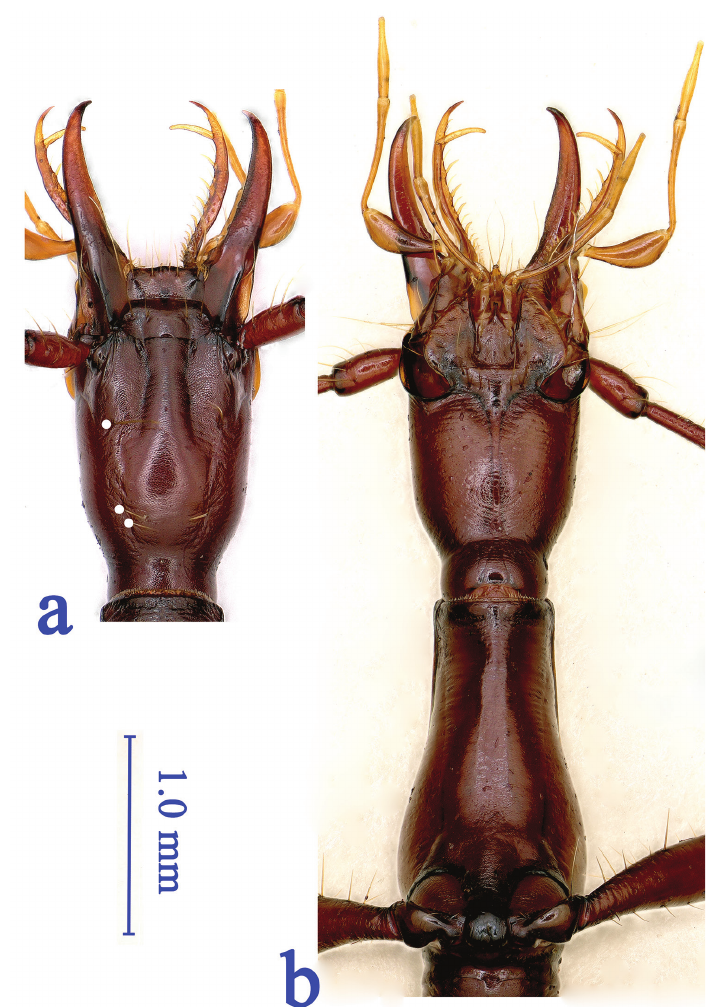
Figure 3. Head and prothorax of Shuangheaphaenops elegans gen. n., sp. n. a head, dorsal view, supraorbital setiferous pores on the left side shown by white points b head and prothorax, ventral view.